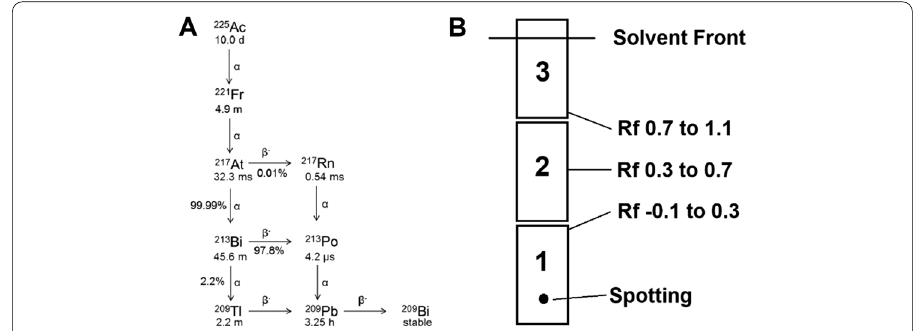
Fig. 2 A Actinium‑225 decay scheme. B General representation of the box grid used to quantify radiolabeling by radioTLC